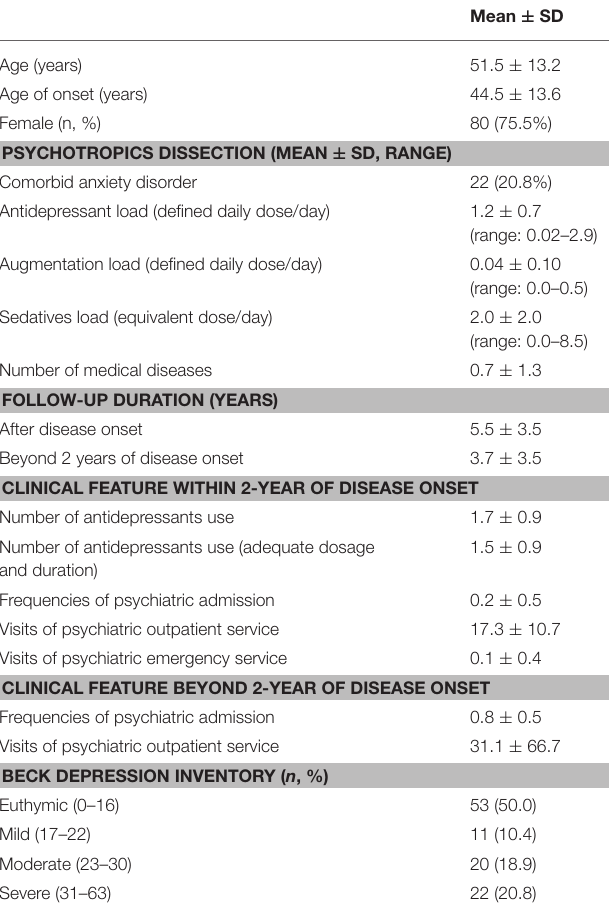
TABLE 1 | Demographic and clinical characteristics of participants ( n =